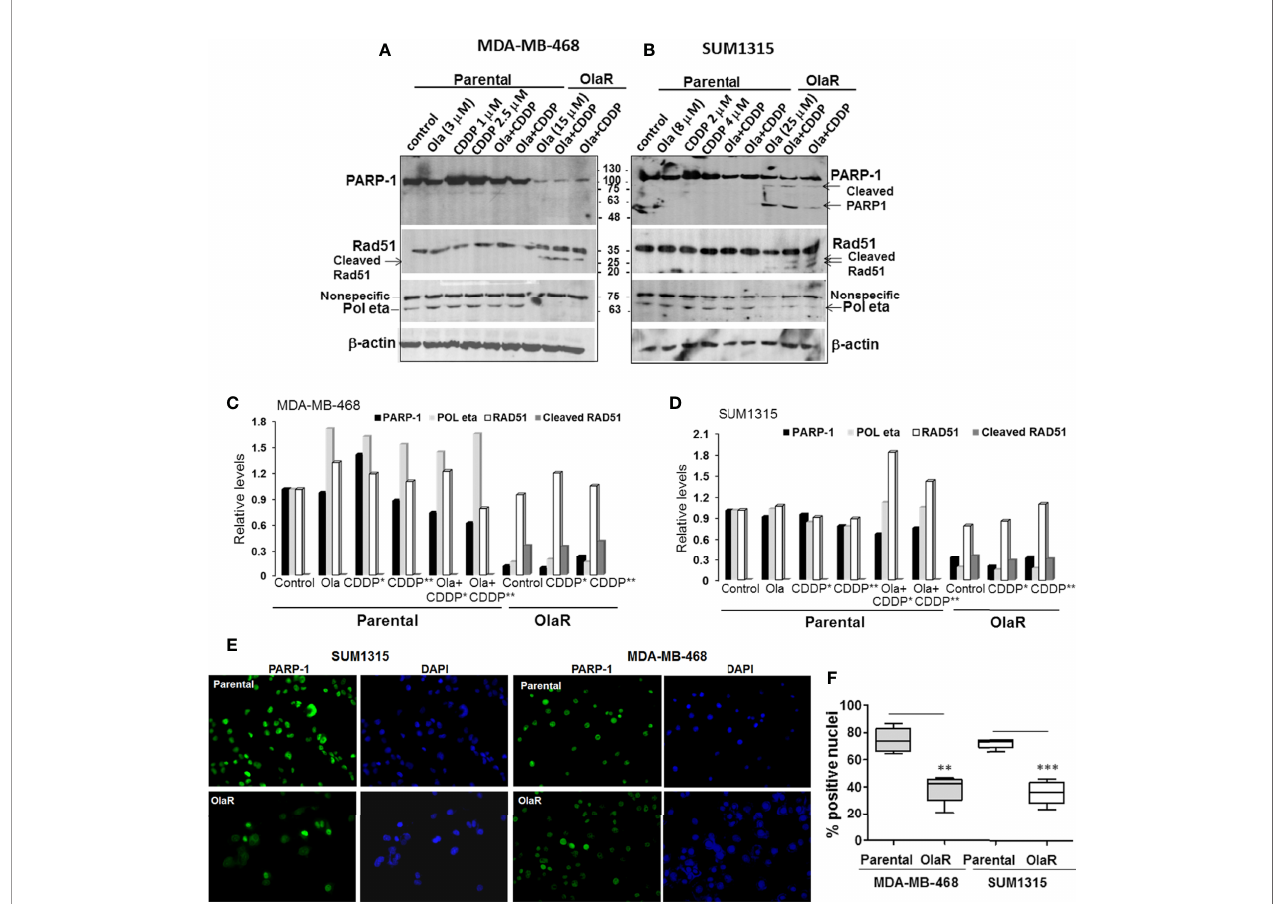
FIGURE 4 | Olaparib resistant (OlaR) TNBC cells show downregulation of PARP-1 and POL h levels, and presence of cleaved RAD51. (A, B) Western blot analysis of the indicated proteins in whole cell lysates of MDA-MB-468 (A) and SUM1315 (B) cells treated overnight singly with olaparib or CDDP, or their combination. (C, D) Quantitation of the relative levels of PARP-1, Pol h and RAD51. Cleaved RAD51 was quantitated relative to native RAD51. (E) Immuno fl uorescence analysis of PARP-1 in parental and OlaR MDA-MB-468 and SUM1315 cells. Magni fi cation ×400. (F) Quanti fi cation of cells with robust nuclear PARP-1 staining. At least 100 cells in four- fi ve fi elds were scored, and results analyzed by 2-tailed Student ’ s t test. **P < 0.01, ***P <